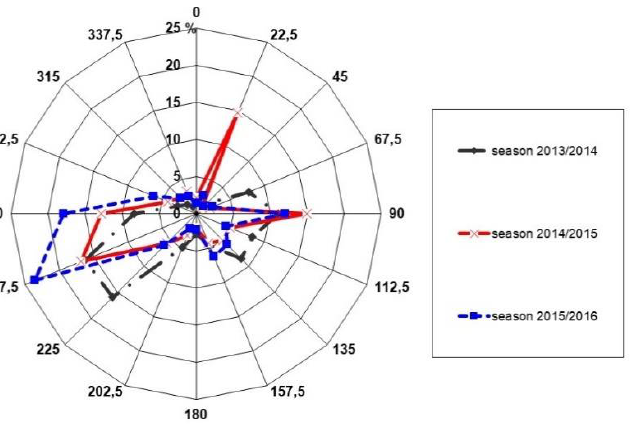
Figure 3. Wind rose for meteorological station, Katowice, seasons 2013/2014, 2014/2015, 2015/2016. The wind directions for this meteorological station were comparable to those of the station in the Katowice agglomeration area and were cited in papers dedicated to the analysis of pollution in this area (Figure 3). The wind roses indicate that these wind directions were dominant for this region, which is meaningful in the context of